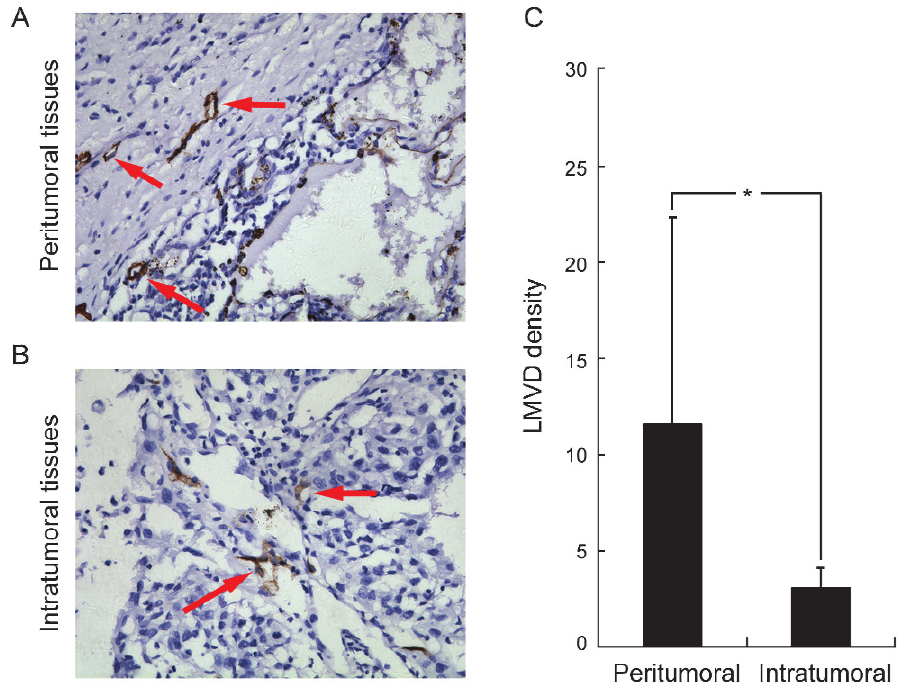
Figure 3 - Peritumoral (A) and intratumoral LMVD (B) in lung adenocarcinoma samples. D2-40-positive staining was detected in lymph vessels by immunohistochemical staining ( 6 400, SP method). The red arrow indicates the LMVD detected in lung tissues. (C) The LMVD of lung adenocarcinoma tissues and adjacent peritumoral tissues. * p